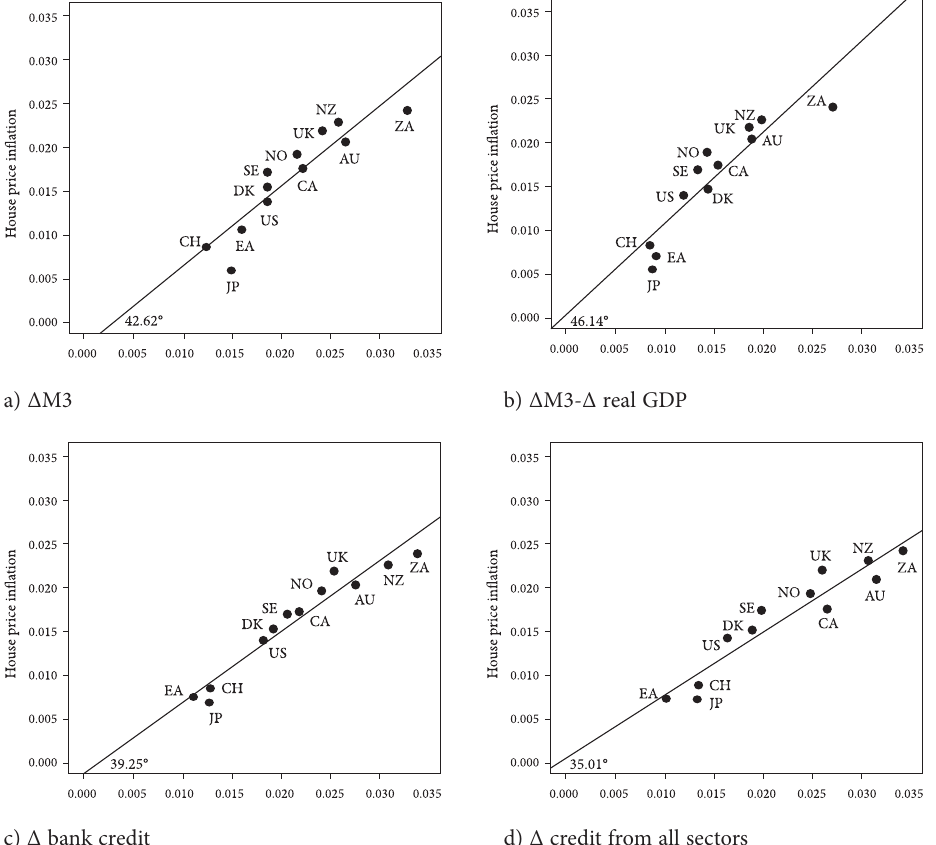
Figure 1. Average quarterly money/credit growth versus house price inflation from 1Q 1970 to 4Q 2016 (source: